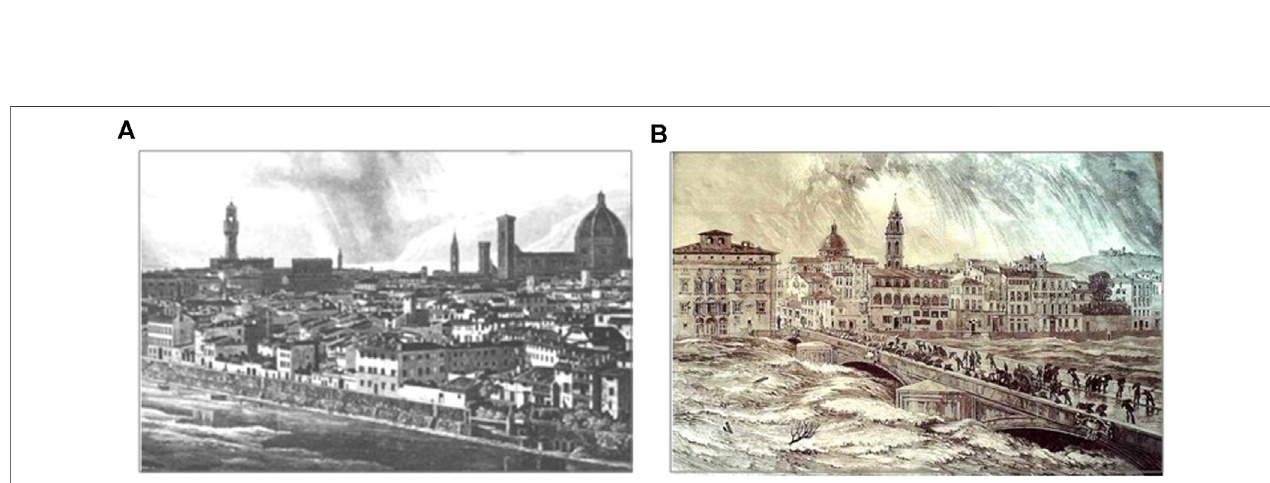
FIGURE 2 | Overview of Florence landscape under diluvial storms. (A) Arno, near the city of Florence, in its original con fi guration (as presented by Menduni, 2017) dating back to1287, in an engraving made shortly before the work for Florence enlargement designed by Giuseppe Poggi (1811 – 1901), and (B) the fl ood of the river on November 4, 1844 (from https://www.conosci fi renze.it/libri-free-su- fi renze/335-Inondazioni-in-Firenze-1844-1864.html).